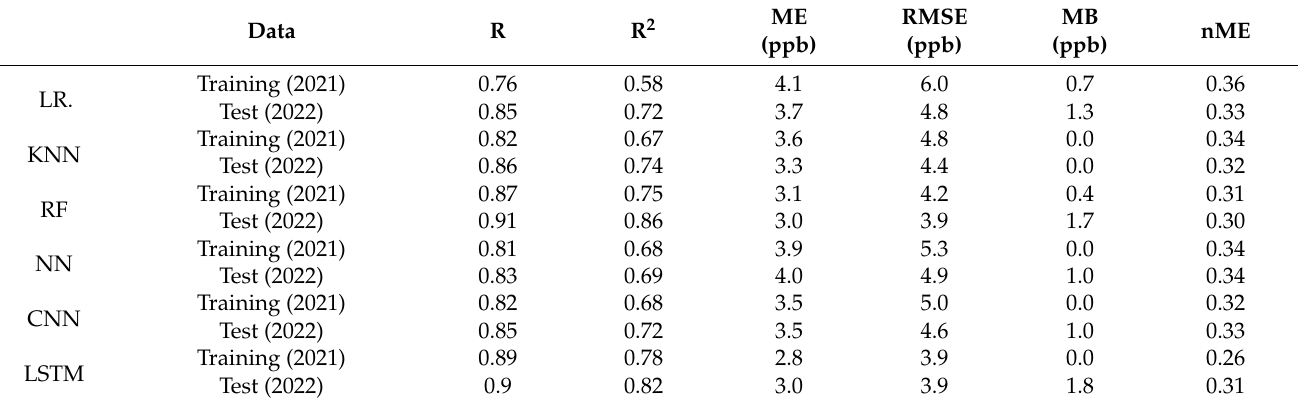
Table 4. Agreement metrics between the reference NO 2 concentrations and the corrected ENSENSIA readings.